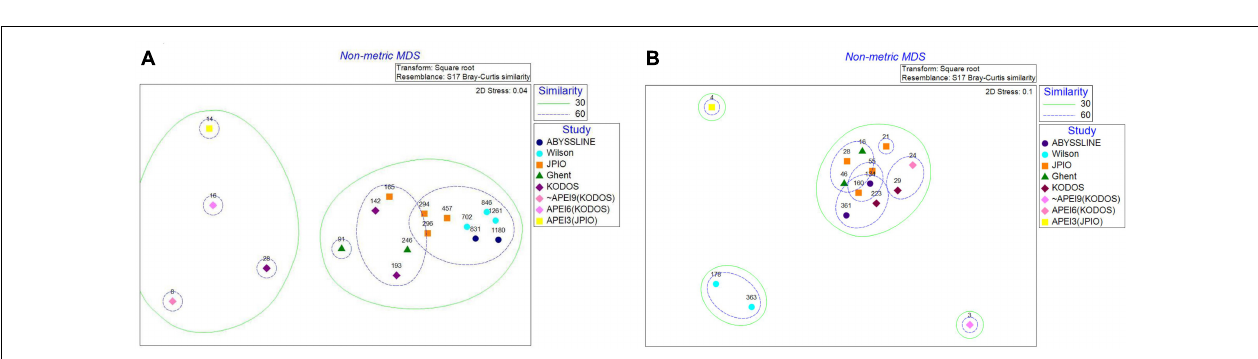
FIGURE 12 | NMDS plots of (A) polychaete and (B) tanaid family community structure for contractor areas and in or near APEIs. Dashed lines bound sites with 30 and 60% similarity. Numbers above points represent the number of individuals collected at each